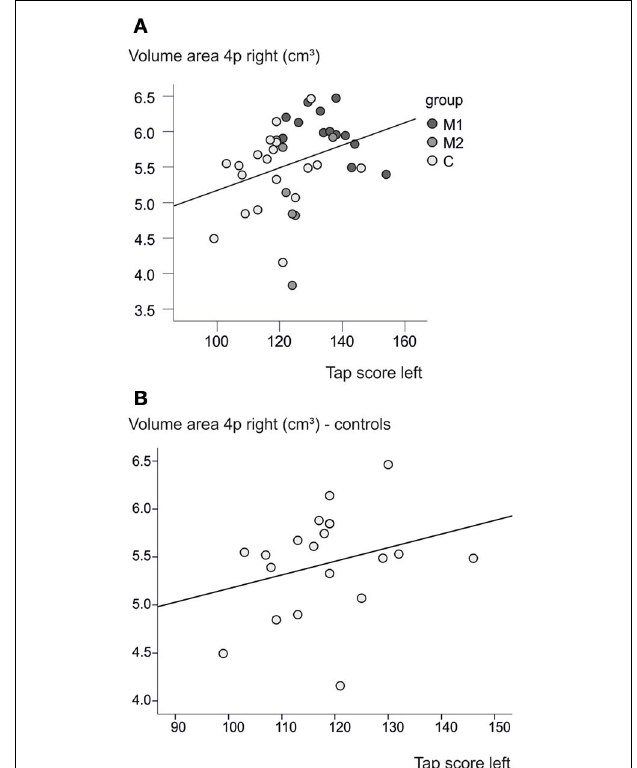
FIGURE 7 | Brain volume and behavior. (A) A higher tapping score of the left hand is associated with a greater volume in right area 4p ( p = 0 . 045, R 2 = 0 . 102). (B) A slight effect can be seen also within the control group without the correlation analysis reaching significance ( p = 0 . 23, R 2 = 0 .